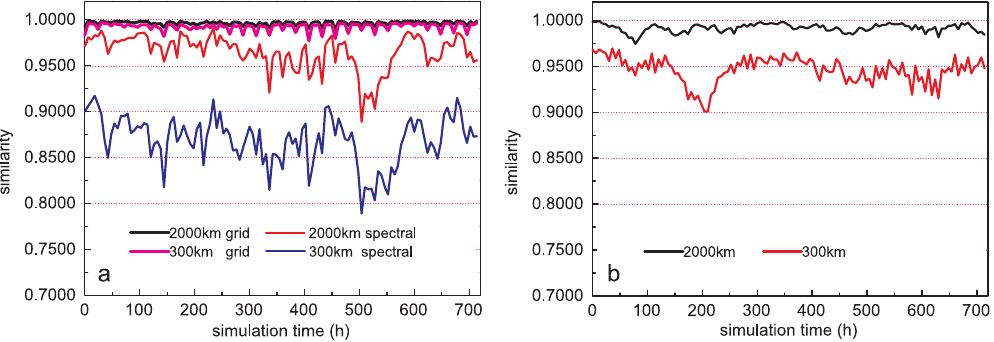
Fig. 5. Time series plots of similarity for water vapor mixing ratio at 500hpa, 2000km and 300km scales for July 2009. (a) similarity between NCEP/NCAP and downscaling results by WRF by grid and spectral nudging; (b) similarity between NCEP/NCAR and NARR data set.